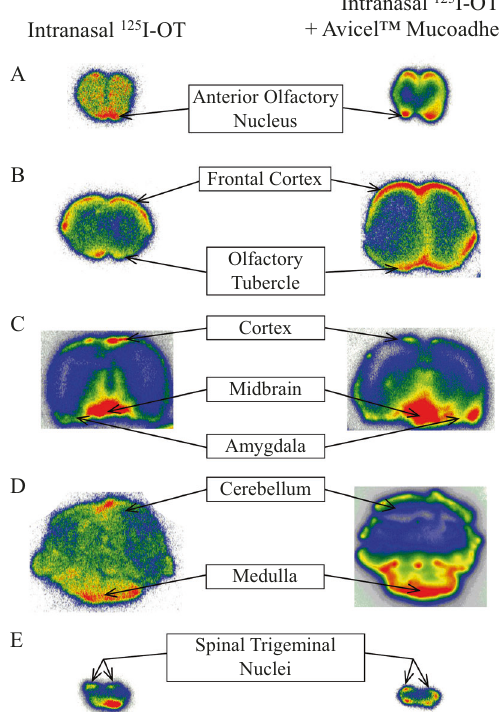
Fig. 1 Qualitative distribution throughout brain tissue after intranasal 125 I-oxytocin (OT) with or without the addition of 1% Avicel ™ mucoadhesive. Autoradiograms of selected representative brain tissue slices illustrate the distribution of radiolabeled OT throughout the rat brain following intranasal administration with (left series of images) or without (right series of images) addition of 1% Avicel ™ mucoadhesive in the formulation. Labels indicate for brain regions of interest the signal observed using the closest- available reference point among the representative slices. Full series of brain tissue slices for individual animals are presented in Supplemental Materials. The addition of Avicel ™ mucoadhesive did not appreciably change the distribution of radiolabeled OT. High signal was detected in the anterior olfactory nucleus, olfactory tubercle, and cortex consistent with transport along the trajectory of the olfactory nerve; high signal in medulla/spinal trigeminal nuclei is consistent with transport along the trigeminal nerve. In addition, high signal was detected in the midbrain and some signals could be detected in amygdala regions. For intranasal OT without Avicel ™ mucoadhesive (left series) representative slices = ( A ) rat 16, A/P + 6; ( B ) rat 12, A/P + 3; ( C ) rat 11, A/P − 7; ( D ) rat 14, A/P − 12; ( E ) Rat 13, A/P − 19. For intranasal oxytocin with Avicel ™ mucoadhesive (right series), representative slices = ( A ) rat 29, A/P + 7; ( B ) rat 29, A/P + 3; ( C ) rat 23, A/P − 7; ( D ) Rat 28, A/P − 13; ( E ) rat 29, A/P − 18. See Supplemental Materials for details including full series of brain tissue slices for individual cervical nodes also exhibited a 1.5-fold increase with the addition of mucoadhesive. Within the brain, the addition of mucoadhesive to the dosing solution caused an increase in the concentration of several rostral tissues including olfactory bulbs, anterior olfactory nucleus, frontal cortex, and septal nucleus. However, of these tissues, only the concentrations in the olfactory bulbs increased markedly. In addition, the concentration of OT in the trigeminal ganglion of animals receiving mucoadhesive was only half that of animals that did not receive mucoadhesive. Both groups contained concentra- tions high enough to feasibly activate OT receptors in all CNS tissues studied, especially in the trigeminal system. Animals receiving mucoadhesive had higher concentrations in the extra-